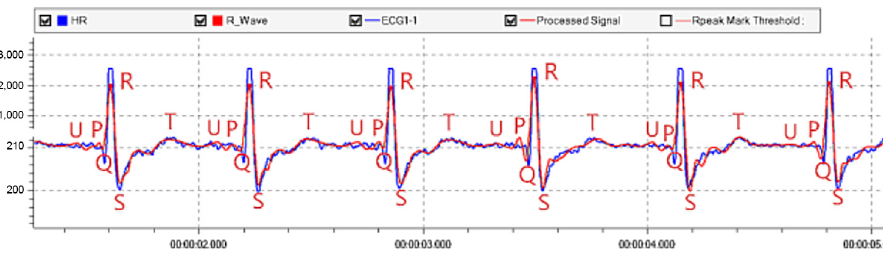
Figure 11 Comparison of ECG signal before and after